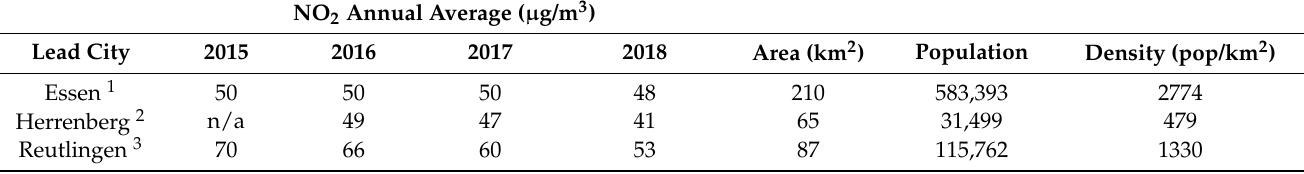
Figure 1. Location of the three cities in Germany (Source: mixmaps.de). Table 2. Characteristics of the three Lead Cities.